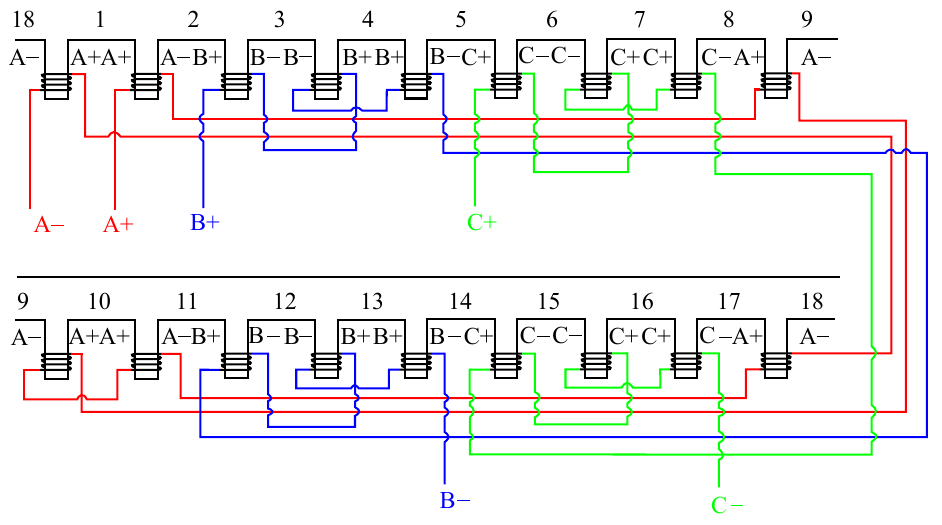
Figure 4. Diagram of the winding of the 18p8 machine.